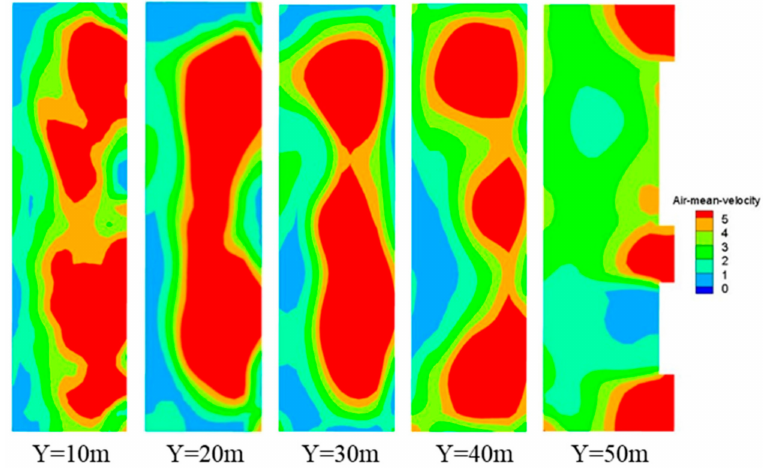
Figure 11. Material concentration distribution along the furnace height